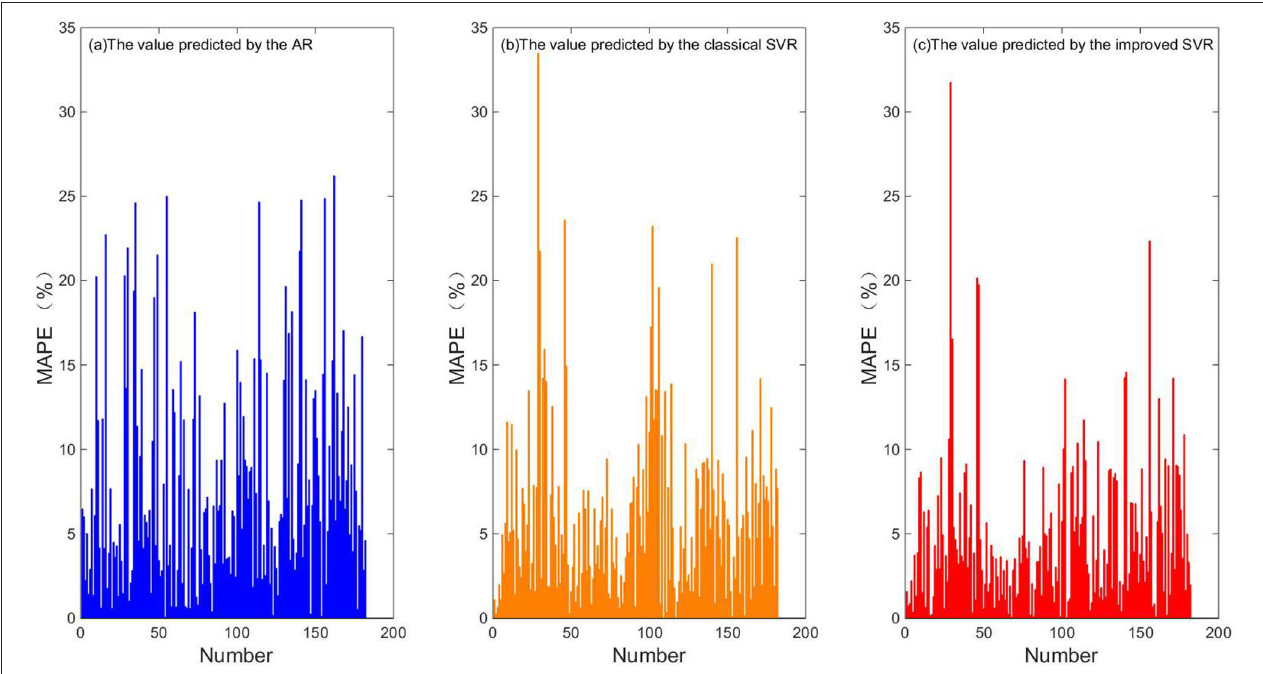
FIGURE 10 | MAPE of evaporation duct heights.